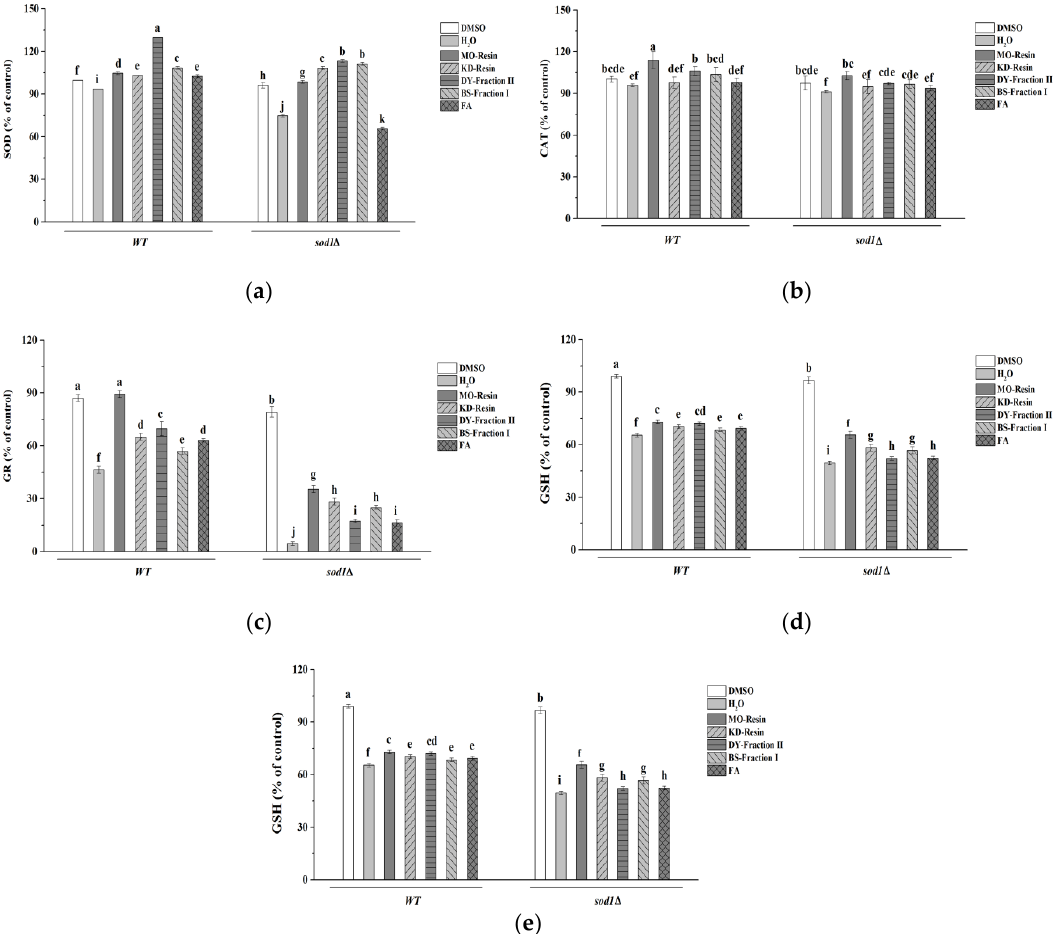
Figure 8. The results of the corresponding enzyme activity of two yeast cells were expressed as the ratio between treated or not treated with herbal teas or green teas. ( a ) SOD activity, ( b ) CAT activity, ( c ) GR activity, ( d ) GSH content and ( e ) GSSG content. The data represent the means ± SD of at least three independent experiments. The capital letters mean statistically different results at p < 0.05.